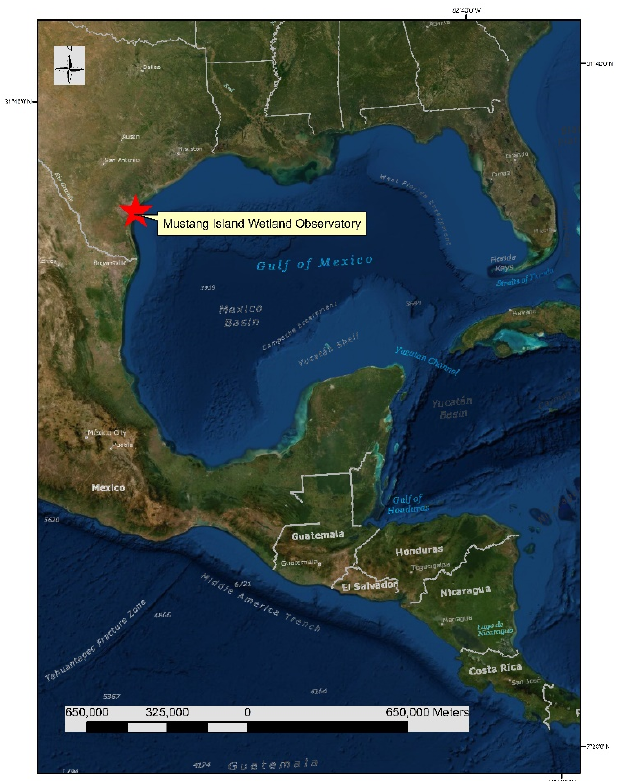
Figure 1. Study area at Mustang Island Wetland Observatory located on Mustang Island along the Texas Gulf Coast, USA. Refer to Figure 2 below for a detailed view of the study site.